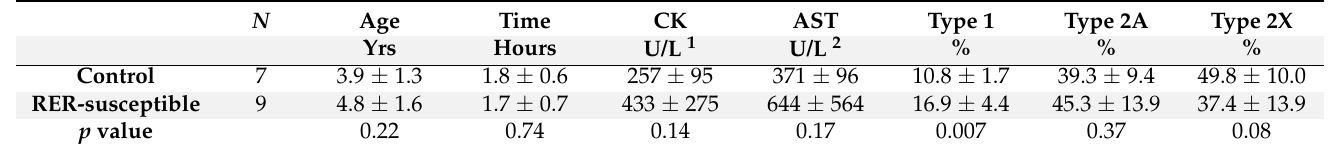
Table 1. The number of control and RER-susceptible mares, mean (SD) age, sex, time lapse between exercise and muscle biopsy, plasma creatin kinase (CK), and aspartate transaminase (AST) activities and fiber type composition for gluteal muscle type 1, 2A and 2X fibers. Information on individual horses is found in Table S1. RER-susceptible horses had significantly more type 1 fibers than